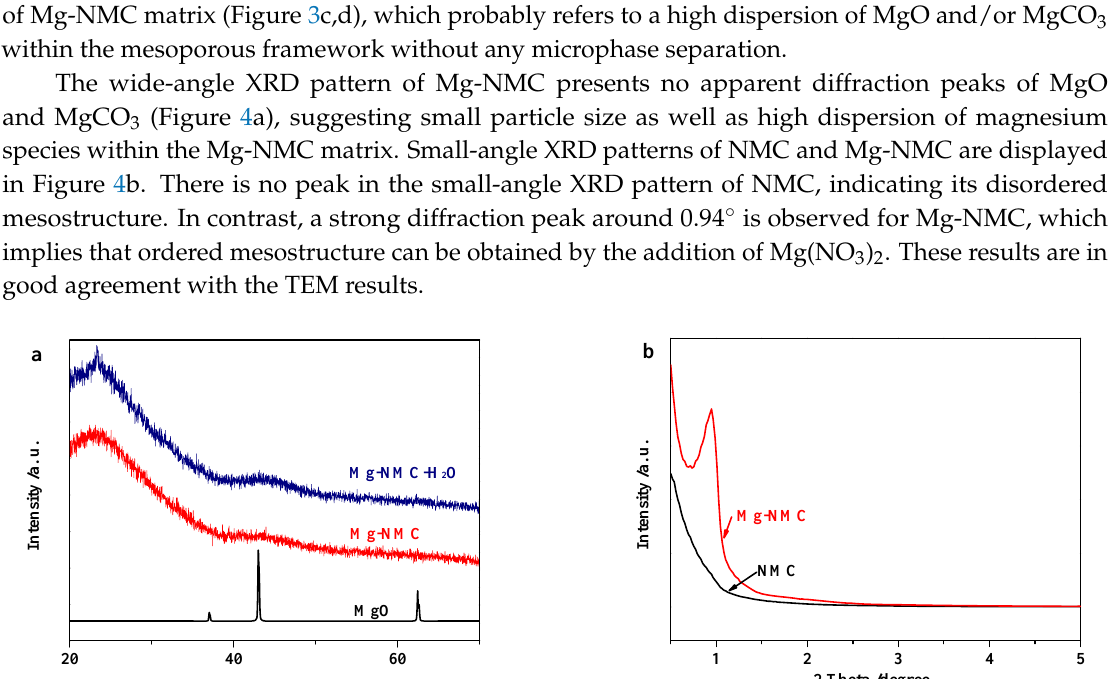
Table 1. Textural properties of NMC, Mg-NMC and Mg-NMC-H 2